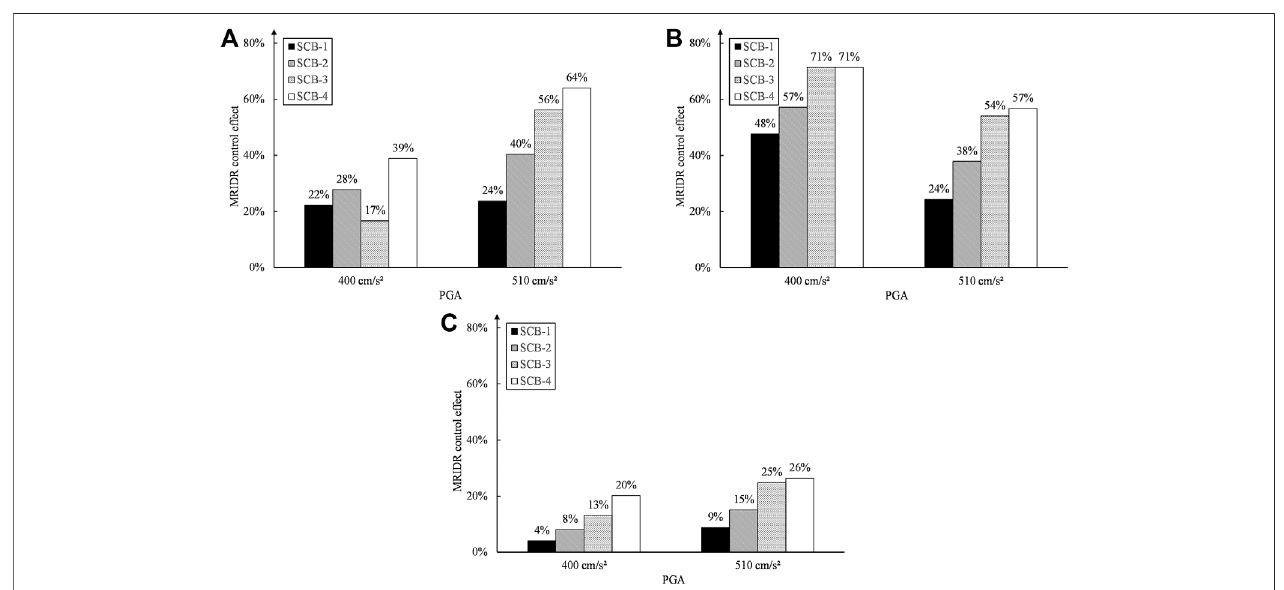
FIGURE 15 | MRIDR control effect of the study cases. (A) 24th story. (B) 51st story. (C) Peak value.